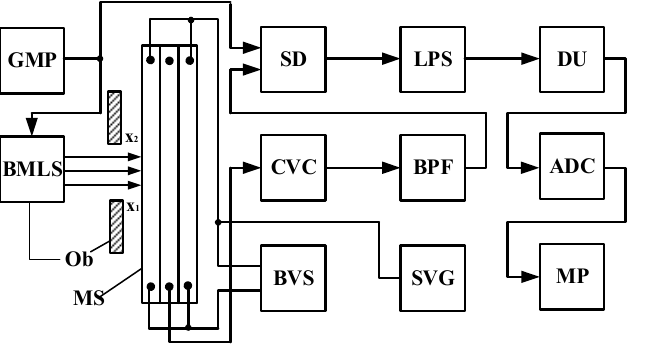
Figure 3. Structure diagram of the noise-proof multiscan-based device for measuring the geometric parameters of objects.